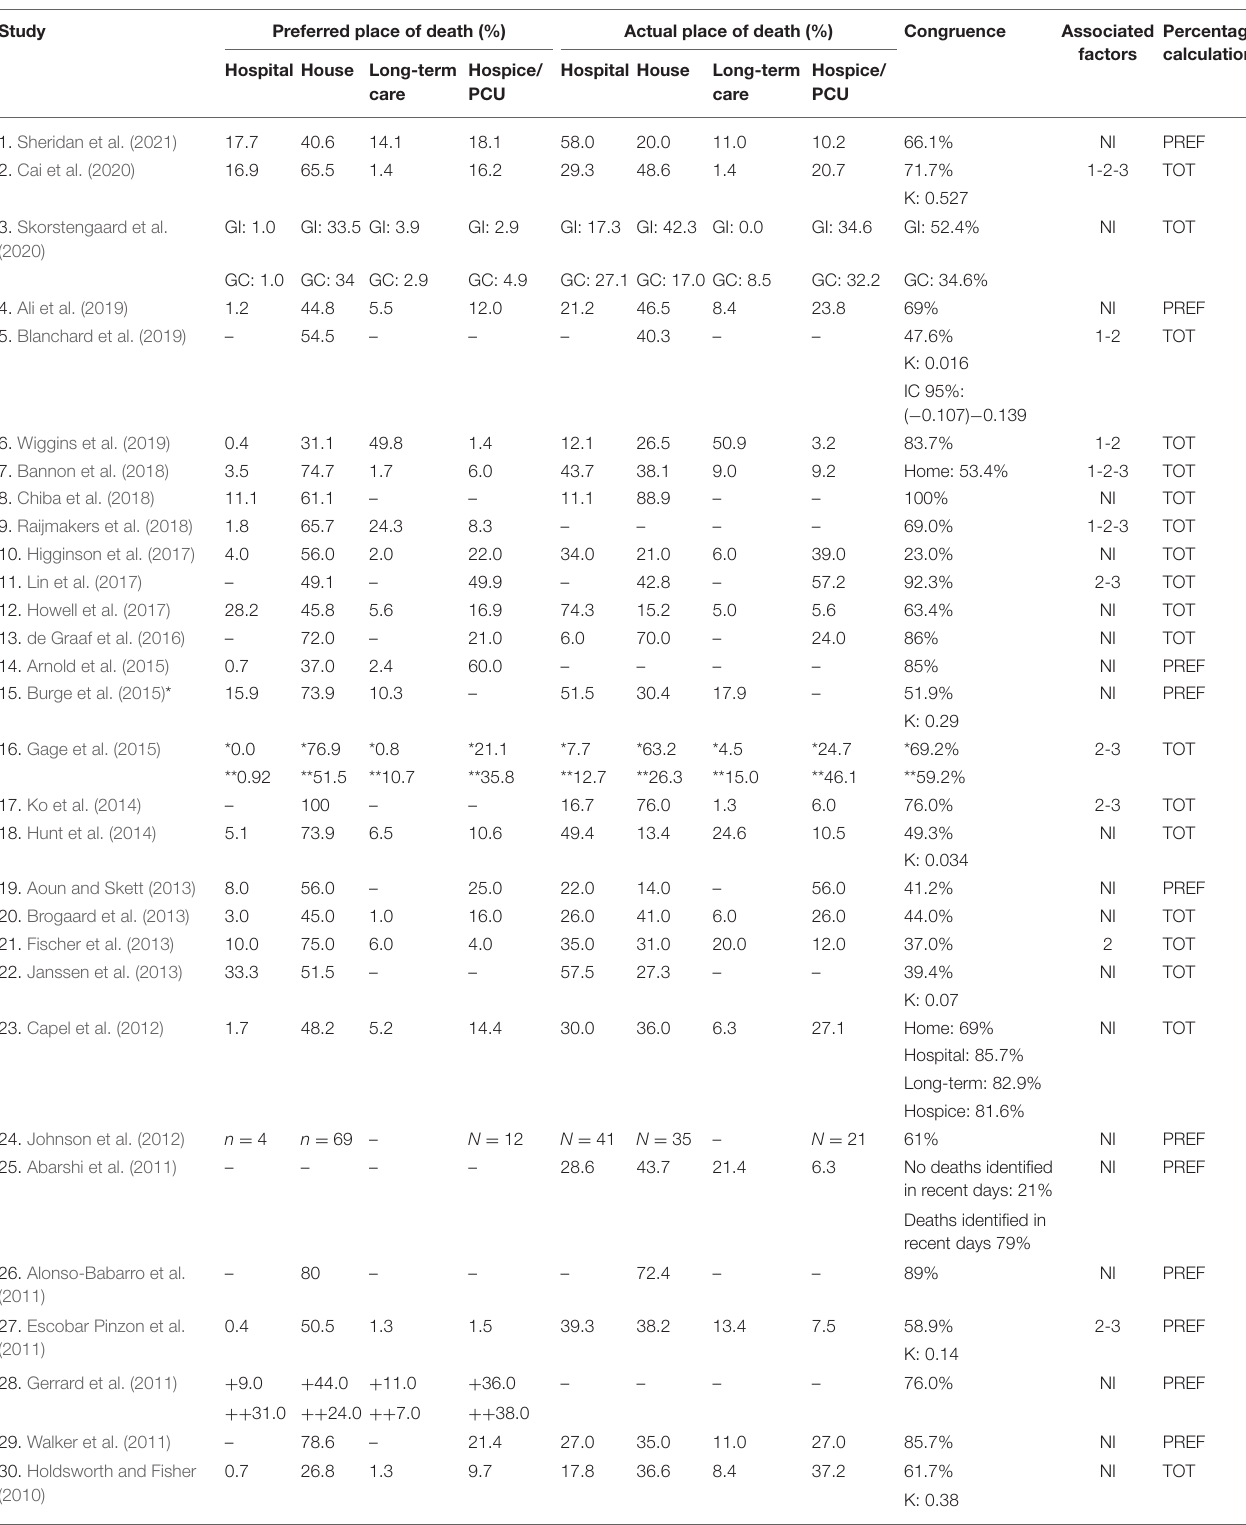
TABLE 2 | Results on preferred place, final place of death, congruence, and the existence of associated factors.